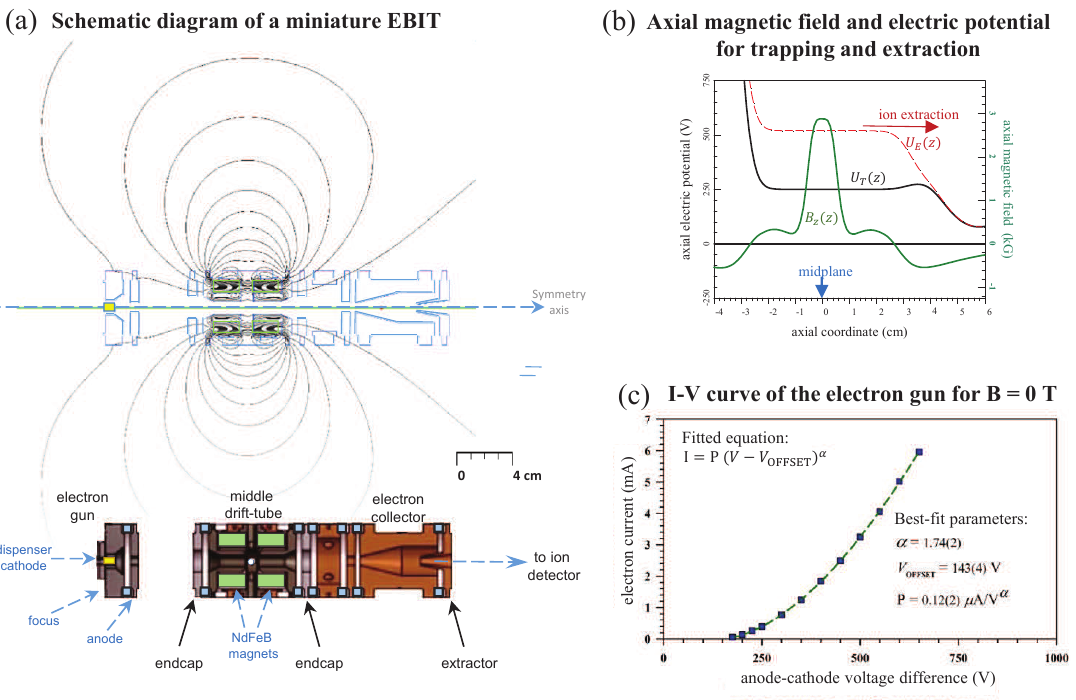
Figure 9. A prototype for studying a miniature EBIT with ion extraction. The schematic diagram ( a ) shows an electron gun that can be repositioned relative to the drift tube assembly. The focus and anode of the electron gun are made of soft iron. The on-axis magnetic field (green line) and electric potential in the drift tube region for ion trapping (black line) and pulsed extraction (red dashed line) are shown in ( b ). The I-V curve of the electron gun ( c ) was measured independently with a Faraday cup biased at 600 V adjoining the anode, with a fit to the data as